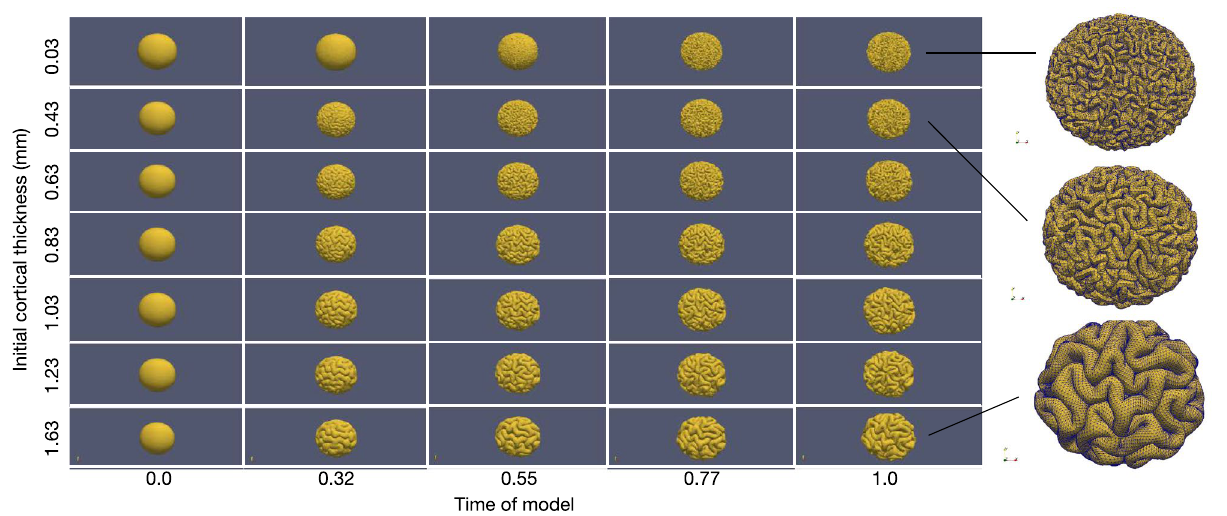
Figure 5. The comparison of folding patterns on reference ellipsoid for different initial cortical thicknesses. Software: ParaView-5.8.0, https:// www. parav iew.